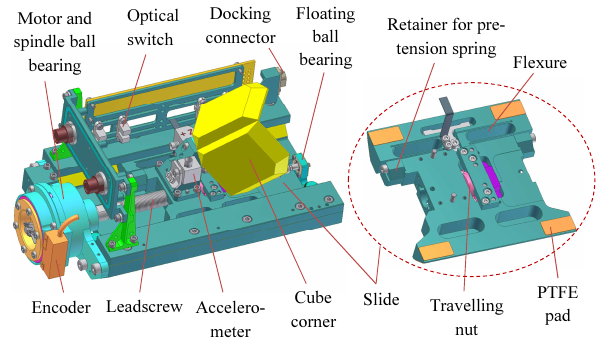
Figure 6. Complete scanner with slide (left) and detail of slide (right). The preloaded dovetail guidance with high contact area and a leadscrew for the feed motion was chosen to get a stiff and rigid